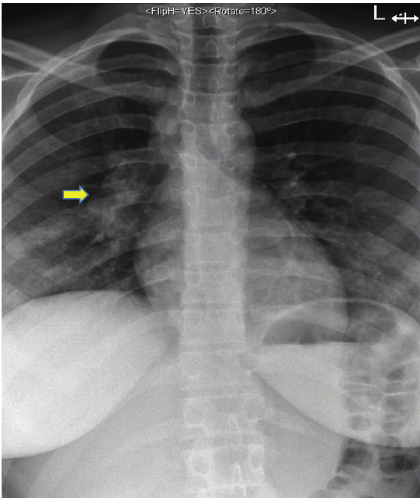
Figure 4: Chest X-ray. Figure 5: Tuberculoma after 1 month (frontal